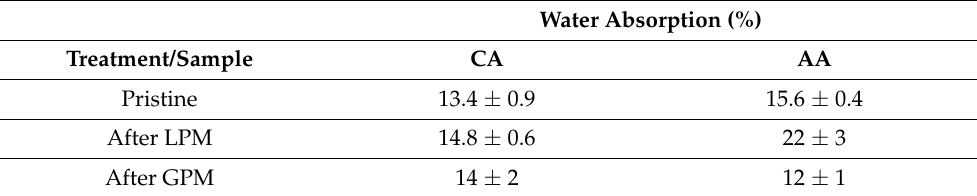
Table 2. Water vapor uptake after 72 h in a controlled humidity chamber at RH 80%.